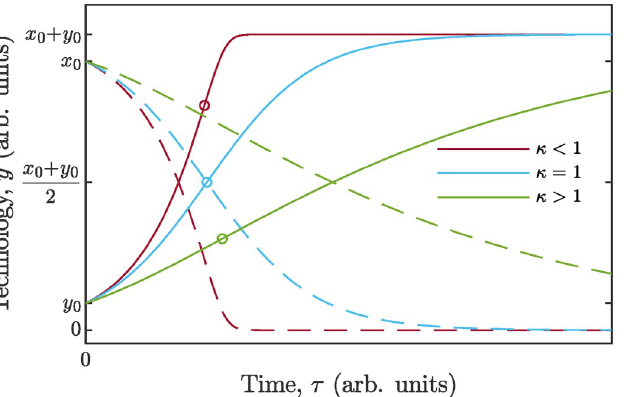
Fig 2. Diffusion of an isolated technology feeding on an exhaustible limiting resource. The nondimensional variables are used (ref. (20)). Solid S -curves depict time profiles of population of firms, dashed lines represent kinetics of resource. The position of an inflexion point (indicated by a circle) on concrete S -curve is determined by the value of the parameter ϰ of the model. In particular, ϰ = 1 yields the logistic growth law.